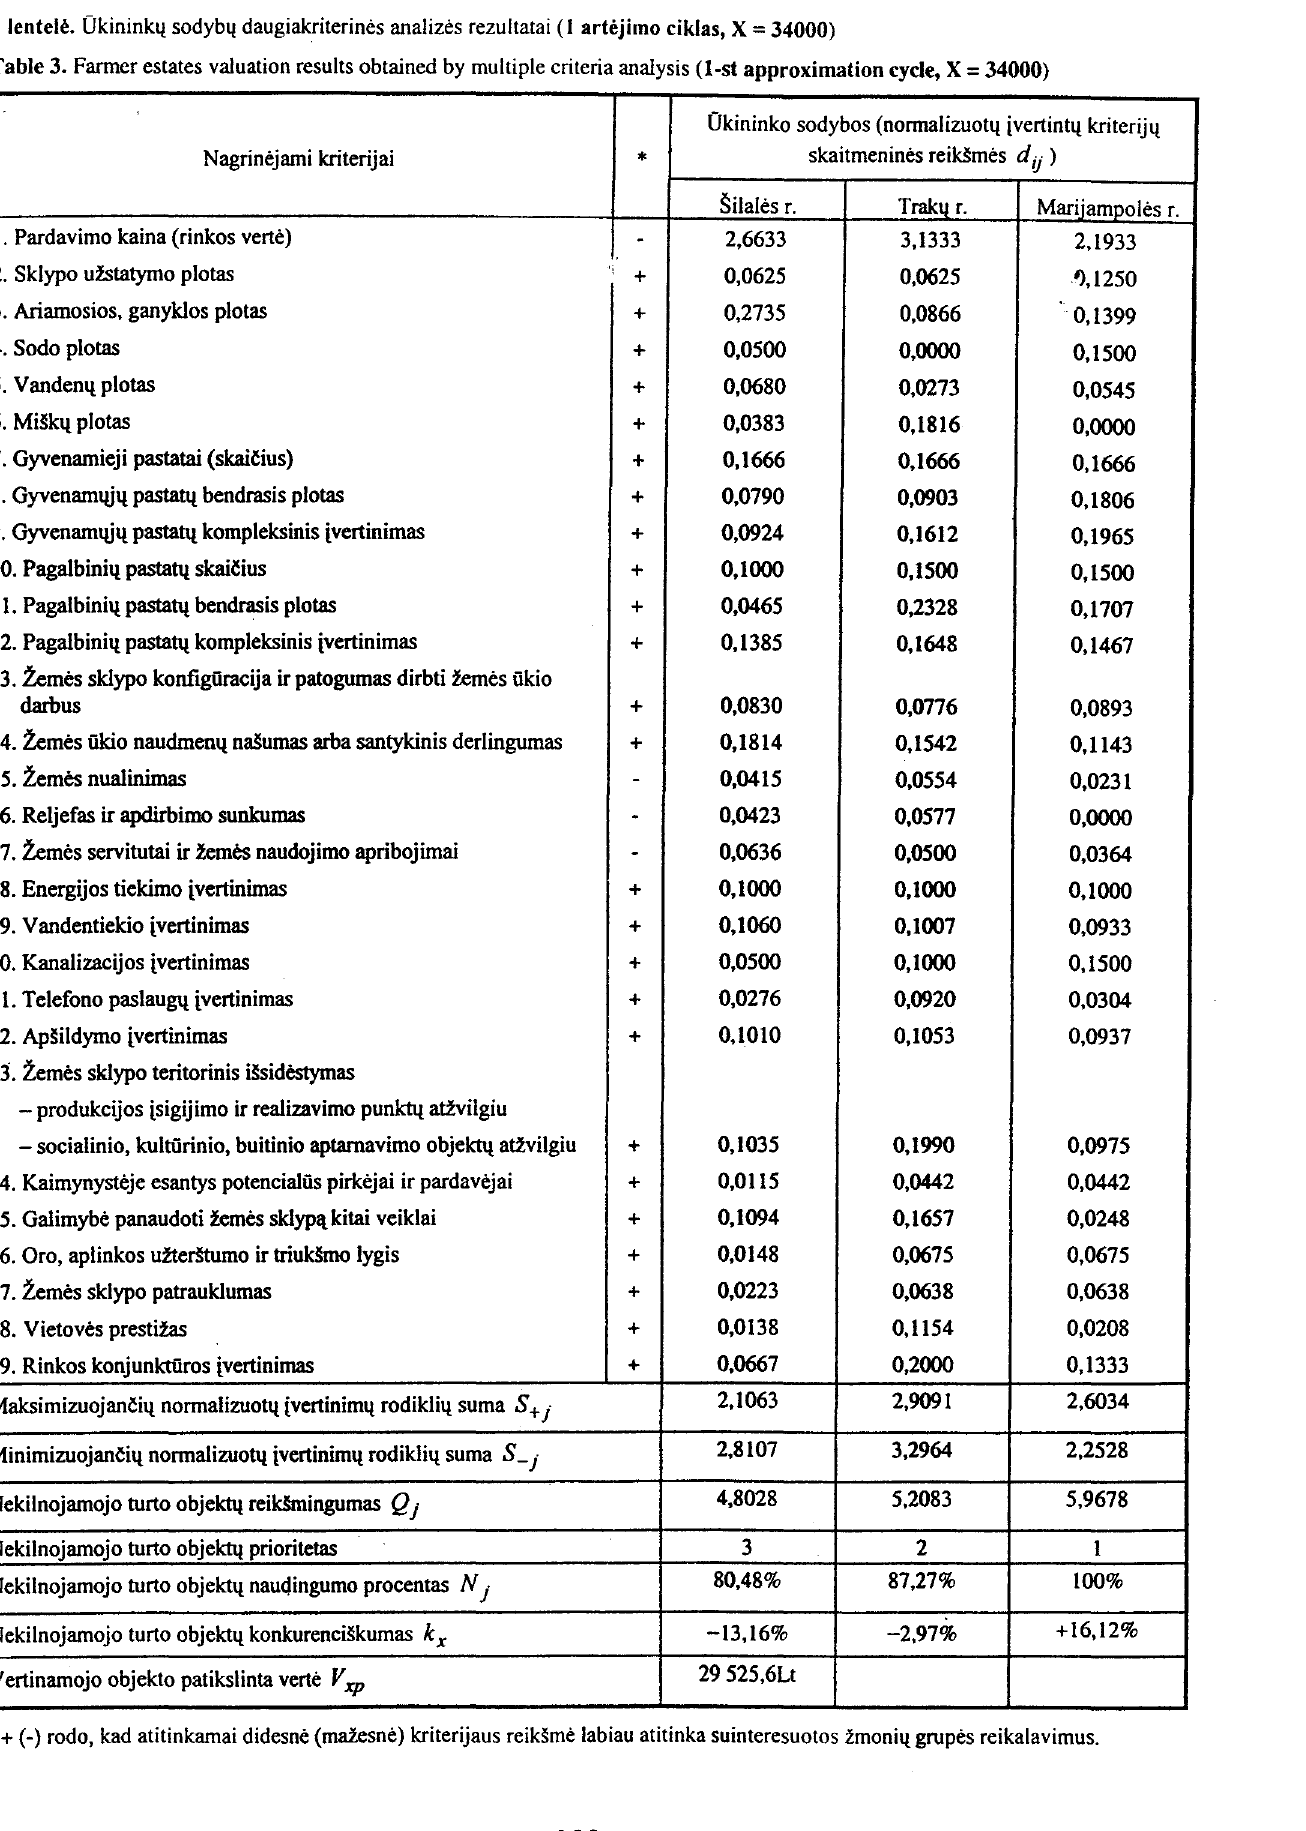
Table 3. Farmer estates valuation results obtained by multiple criteria analysis (1-st approximation cycle, X=